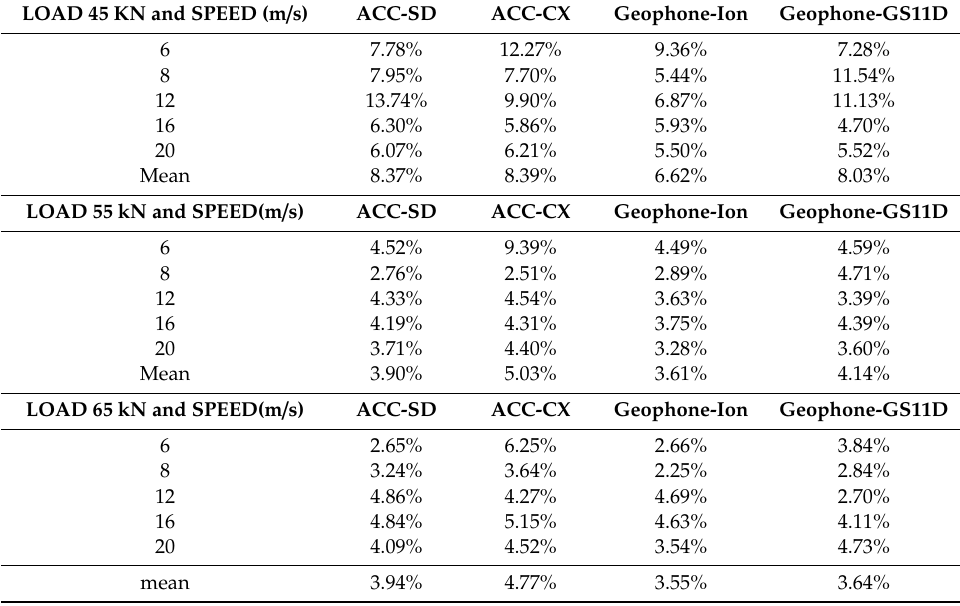
Table 3. relative di ff erences in percentage between the reference deflections (anchored displacement sensors) and those measured by the geophones and accelerometers, for 45, 55, and 65 kN